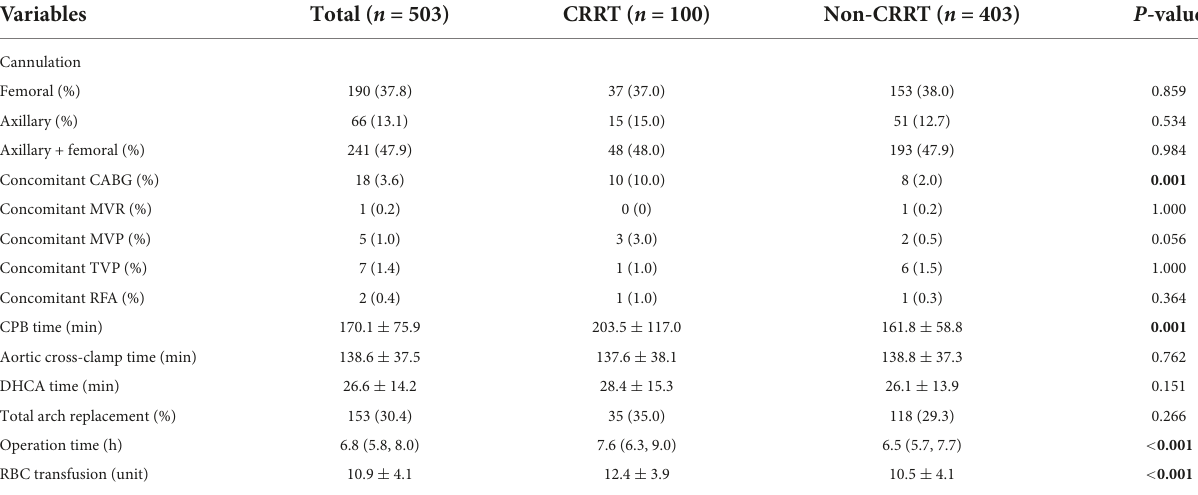
TABLE 3 Comparison of operative